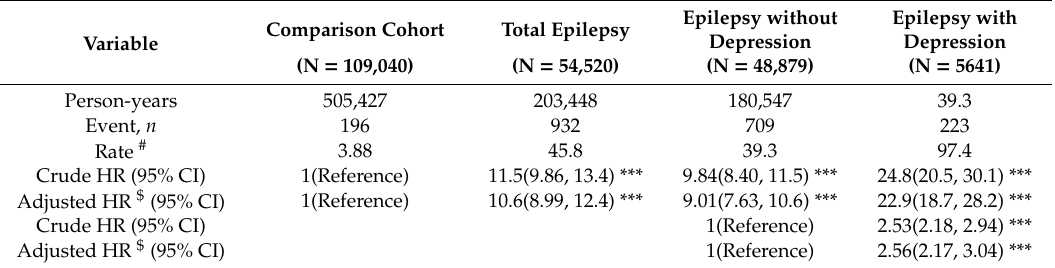
Table 5. Incidence and hazard ratios of suicidal drug overdose in patients with epilepsy stratified according to the presence or absence of comorbid depression by Cox